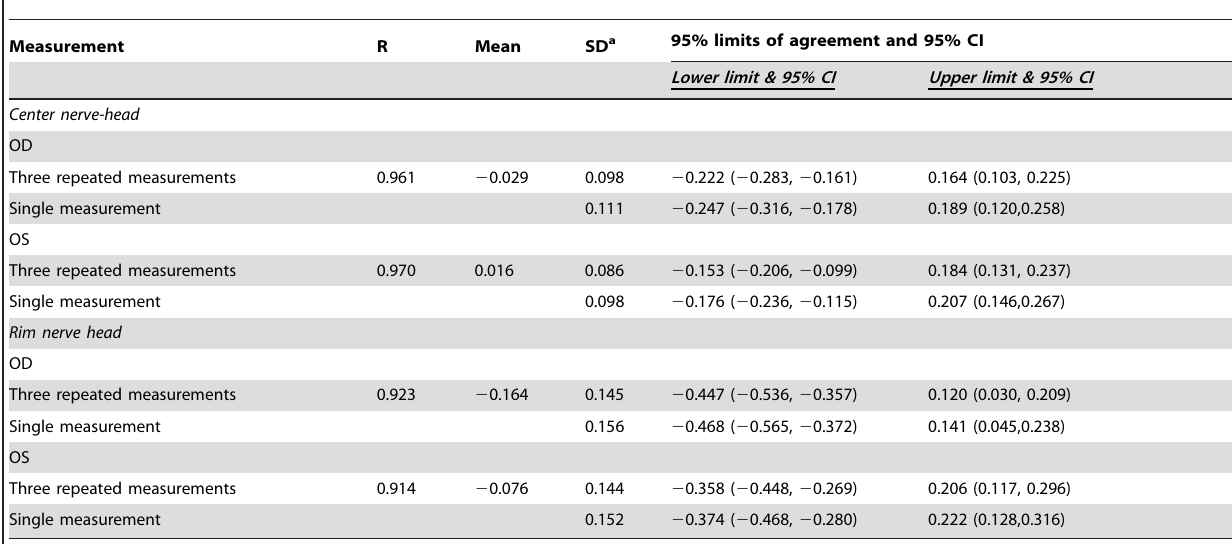
Table 4. Pearson’s correlation coefficient R and agreement measurements for the averages of three measurements made by two observers on the nerve-head to fovea distance (NFD) mm. from the center of the nerve-head and the rim of the nerve-head in 30 right eyes (OD) and 30 left eyes